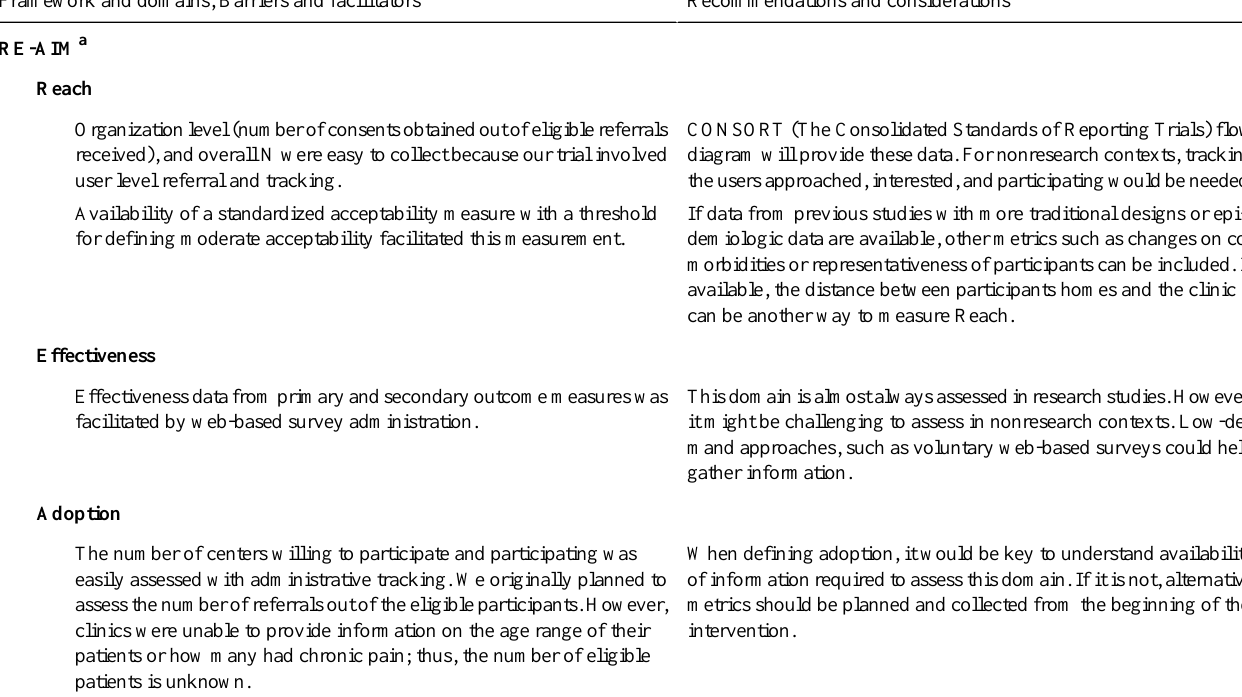
Table 3. Lessons learned: barriers and facilitators to assess the domains of each framework and recommendations for future studies.